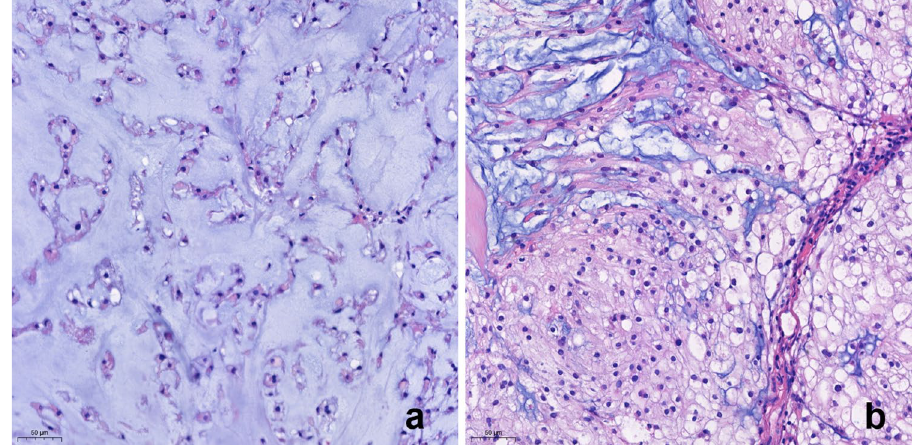
Figure 6. Histology of stroma-rich ( a ) and stroma-poor ( b ) chordomas. ( a ) Stroma-rich chordoma shows extensive myxoid stroma with a few strands of tumor cells. ( b ) Stroma-poor chordoma shows a diffuse nodular proliferation of tumor cells with scant myxoid